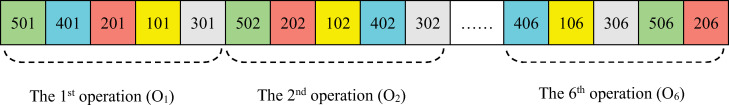
An optimal schedule of the 5×6 JSSP in Example 3.